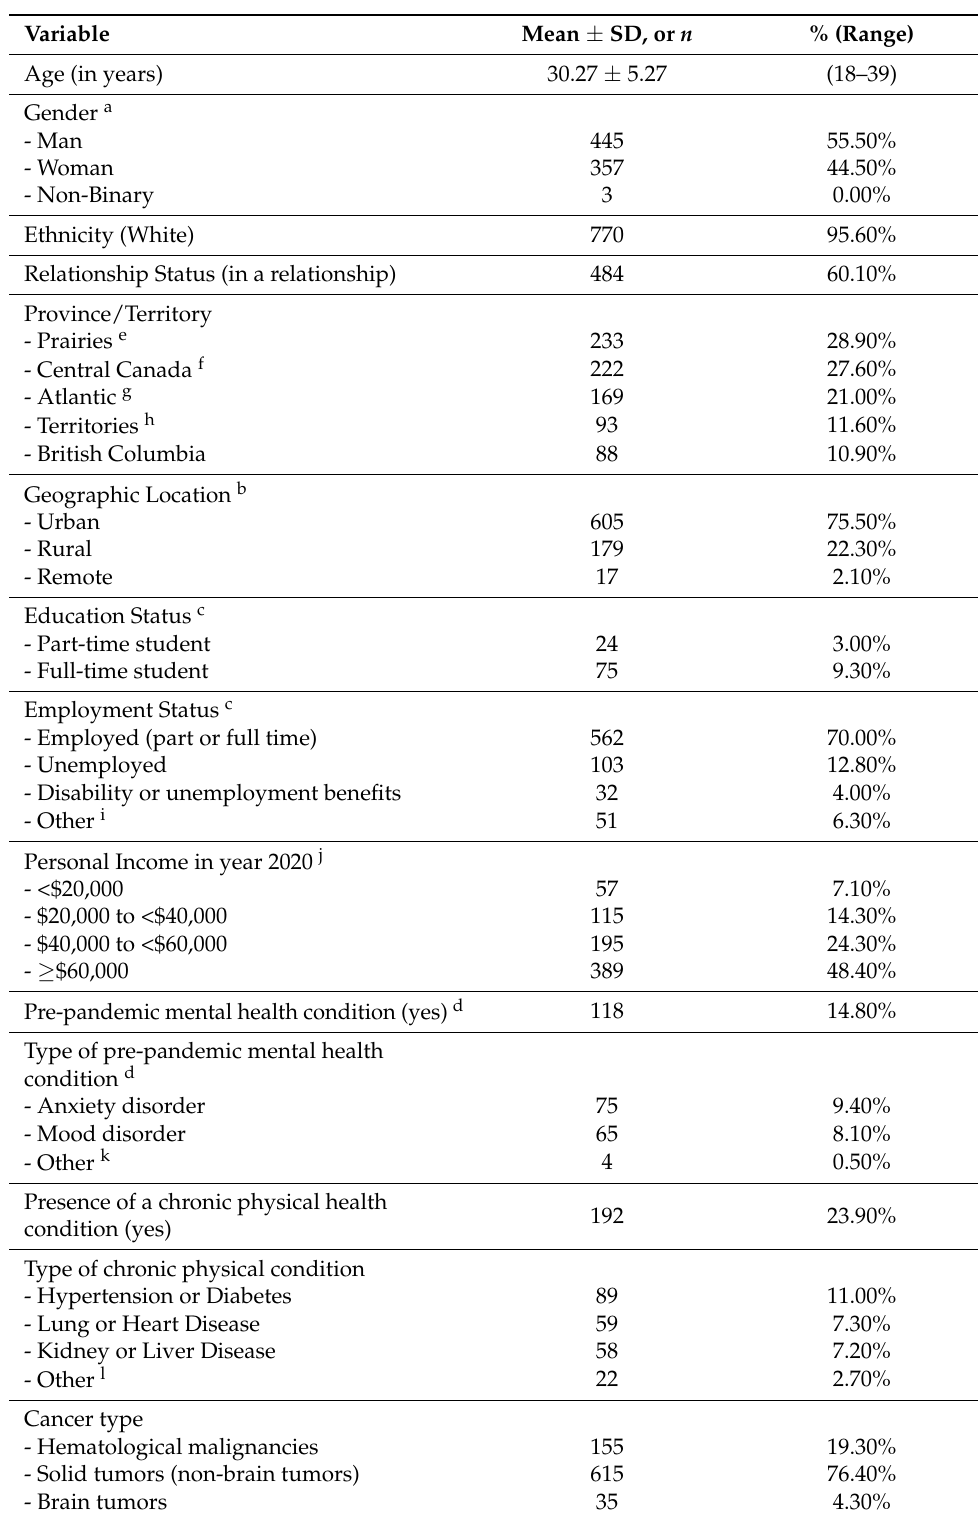
Table 1. Descriptive characteristics of the study population ( n =